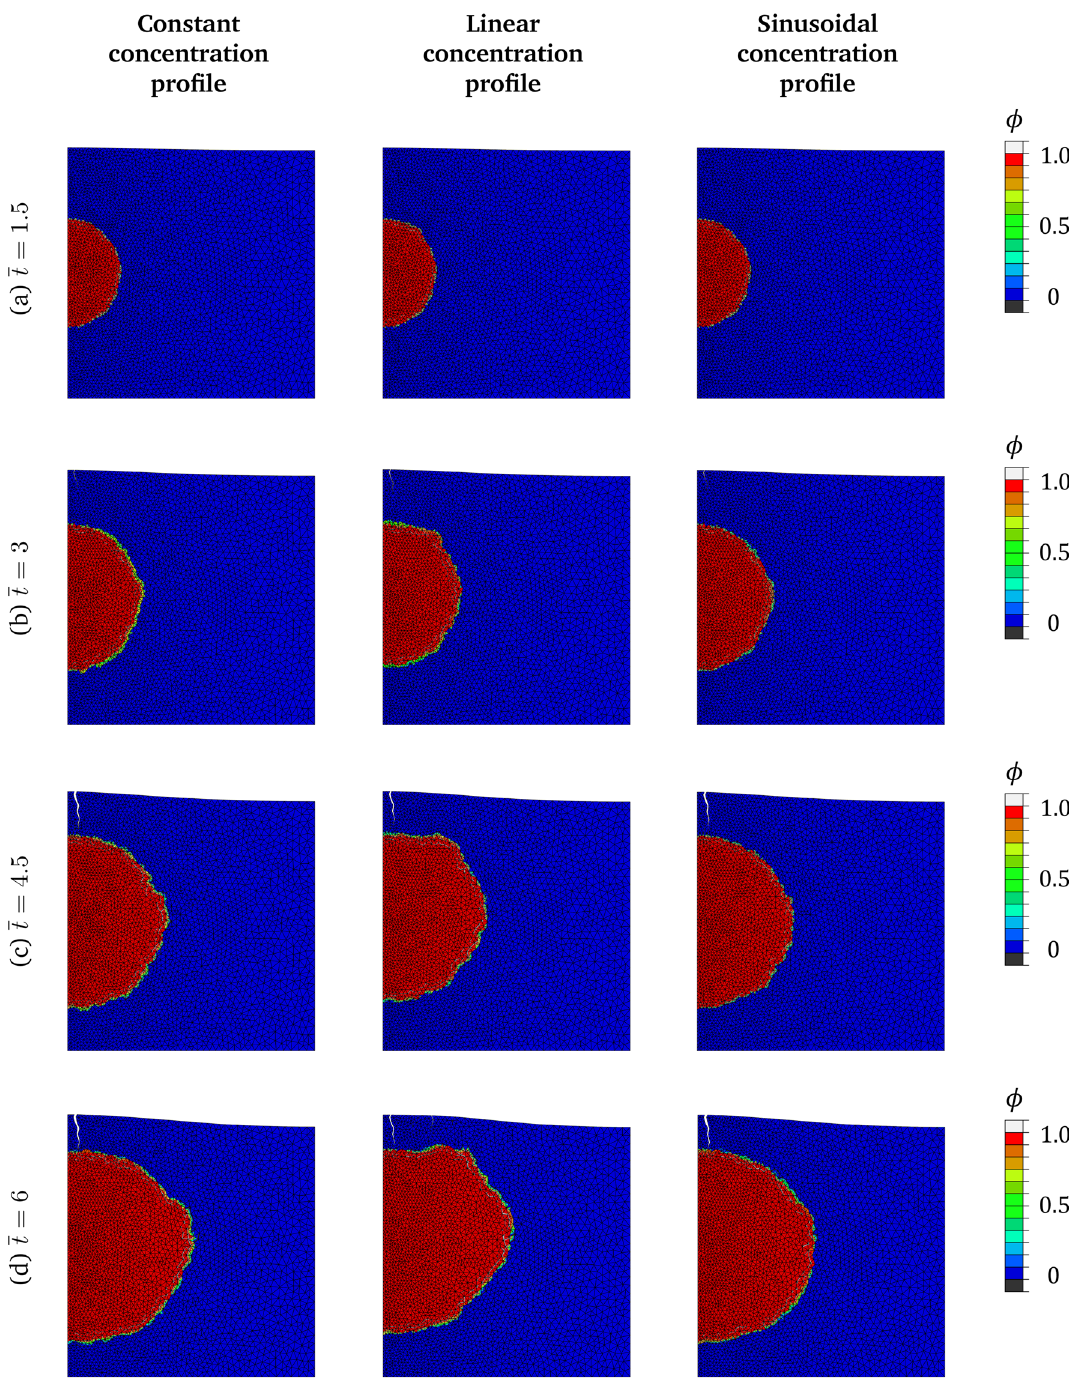
Fig. 6 Time evolution of the paint configuration (with the deforma- tion plotted at true scale) illustrating the growth of the metal soap crystal and the fracture and surface deflection of the paint material. The contour plot variable 𝜙 refers to the volume fraction of crystal-